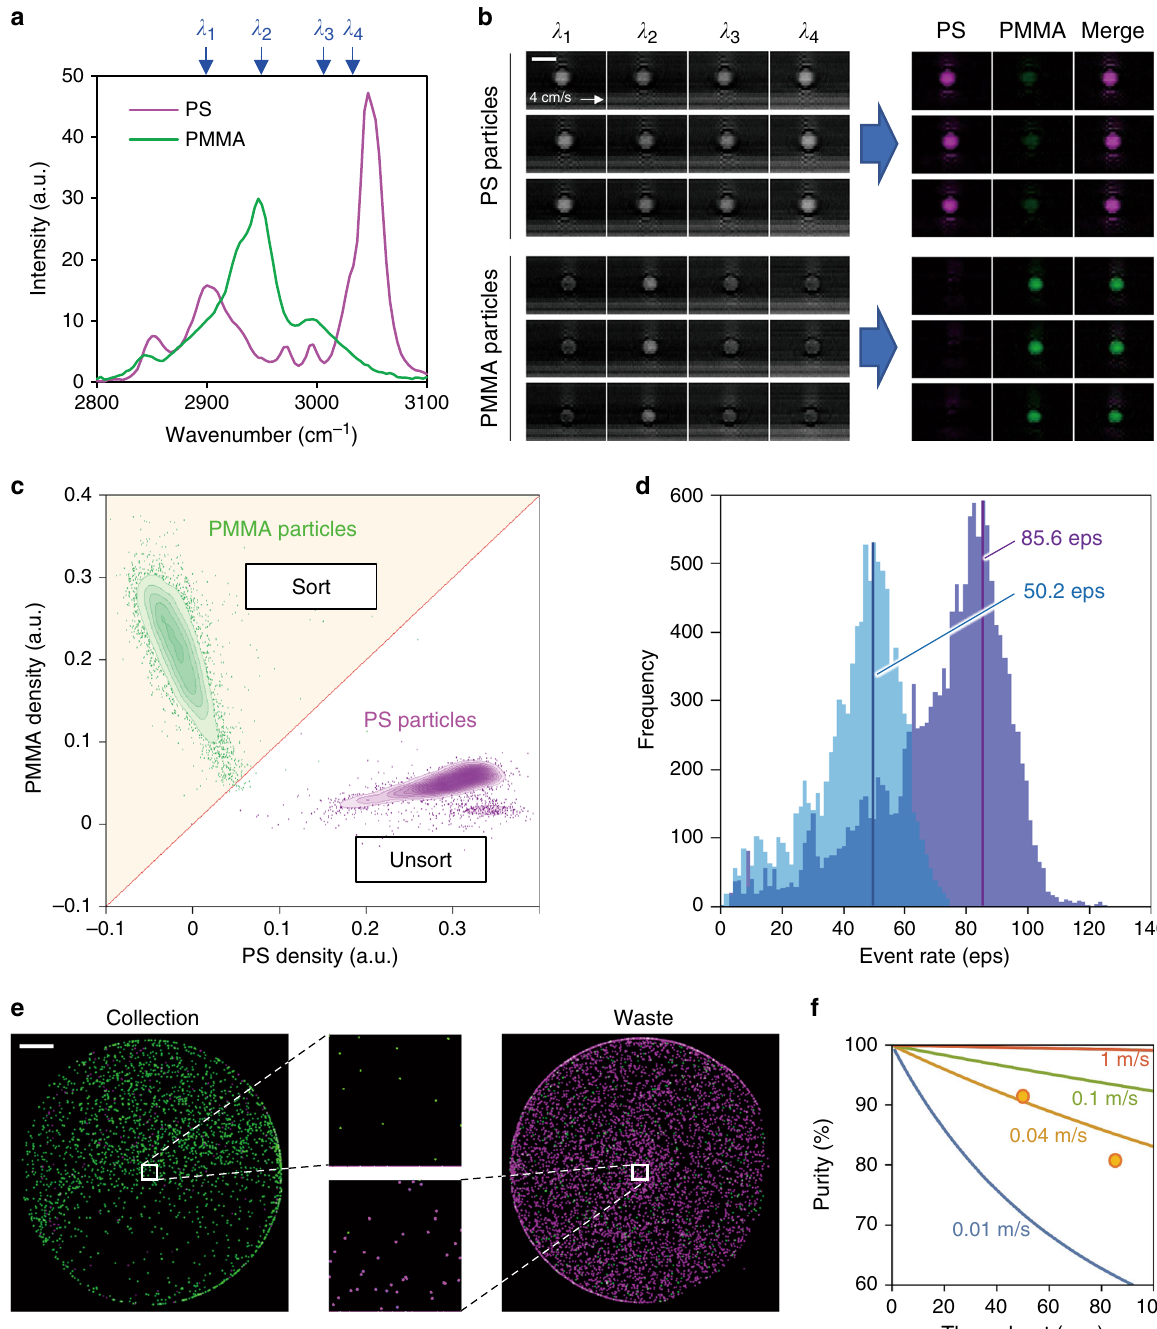
Fig. 2 Basic performance of the RIACS. a SRS spectra of PS and PMMA particles obtained by an SRS microscope. Four wavenumbers (2899, 2954, 3006, 3034 cm − 1 ) were selected and used to decompose SRS images into two chemical species. b SRS images of PS and PMMA particles (representative of n = 9786 and n = 4063, respectively) at the four wavenumbers and decomposed images of the particles. Scale bar, 10 µ m. c Scatter plot of the particles in PS and PMMA intensities per particle area (referred to as PS/PMMA densities) with the sort region (yellow). d Histograms of event rates in two sorting experiments (nominal throughput values: 50.2 eps, 85.6 eps). e Fluorescence images of sorted and unsorted particles in the collection and waste tubes, respectively ( n = 2). The insets show enlarged images of the sorted and unsorted particles. Scale bar: 1 mm. f Theoretical estimation of the throughput- purity relation at various fl ow speed values together with our experimental veri fi cation (orange 3T3-L1 cells ” , “ preparation of hiPSCs ” , “ preparation of Chlamy- domonas sp. mutant cells ” , and “ preparation of Euglena gracilis